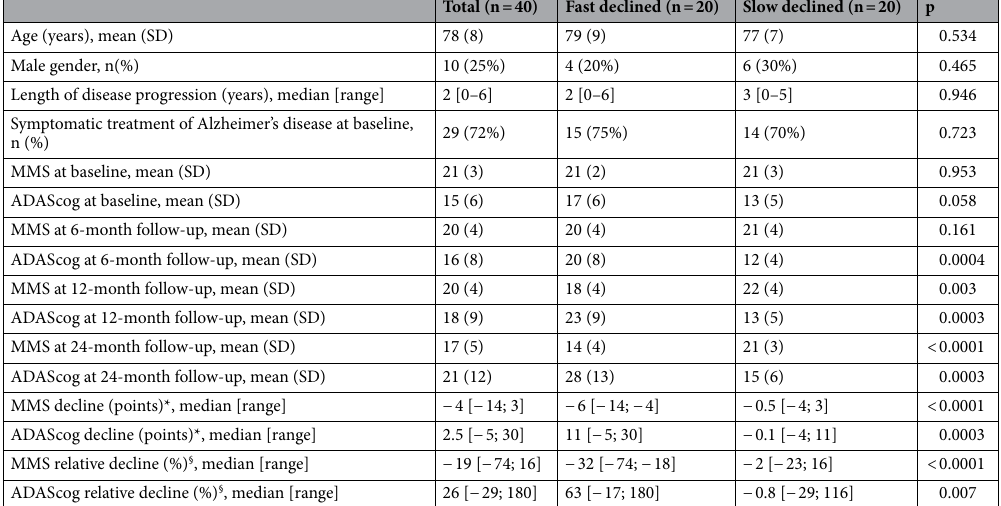
Table 1. Clinical characteristics and neuropsychological performance at baseline and through clinical follow-up at 6, 12 and 24 months from the baseline: comparison between fast decliners and slow decliners. SD standard deviation, MMSE Mini-Mental State Examination, ADAS-cog Alzheimer’s Disease Assessment Scale- cognitive subscale. *Decline is the difference: value at M24 minus value at baseline; § relative decline is the ratio (value at M24 minus value at M0)/value at